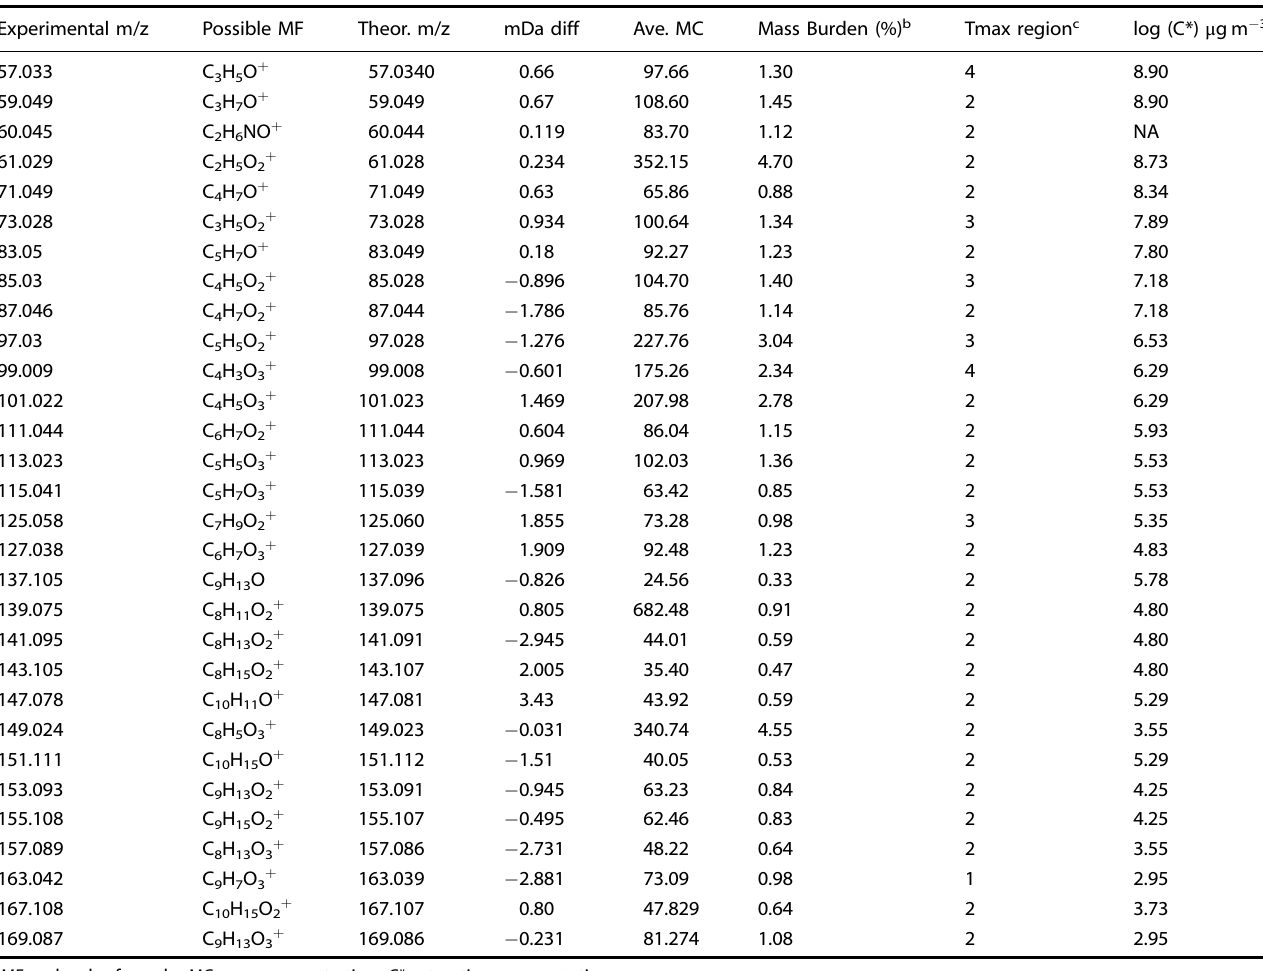
MF molecular formula; MC mass concentration; C* saturation concentration. a Comparison of daytime and nighttime concentration of the major compounds is given in Supplementary Fig. 1. b Mass contribution to total submicron organic matter measured using OC/EC analyzer. – 200 °C; (3) 200 – 350 °C; 350 – 550 °C c Temperature max ( T max ) regions: (1) RT-100 °C; (2) 100